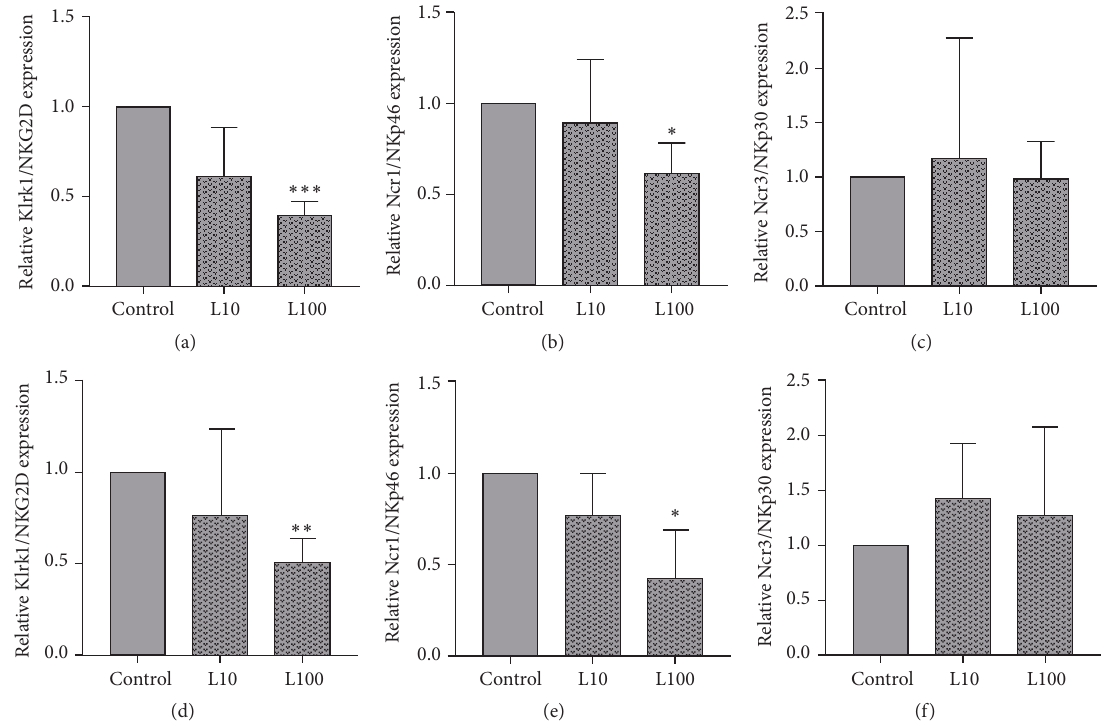
Figure 2: Influence of leptin on the mRNA expression of the activating NK cell receptors Klrk1/NKG2D (a, d), Ncr1/NKp46 (b, e), and Ncr3/NKp30 (c, f). NK-92 cells were incubated in the absence or presence of 10ng/mL (L10) or 100 ng/mL (L100) leptin for 4 h (a–c) or 24 h (d–e). Results are expressed as the mean ± SEM fold-change compared to control cells, from three individual experiments with each 𝑁 = 4 well. ∗ 𝑃 < 0.05 , ∗∗ 𝑃 < 0.01 , and ∗∗∗ 𝑃 < 0.001 compared to control